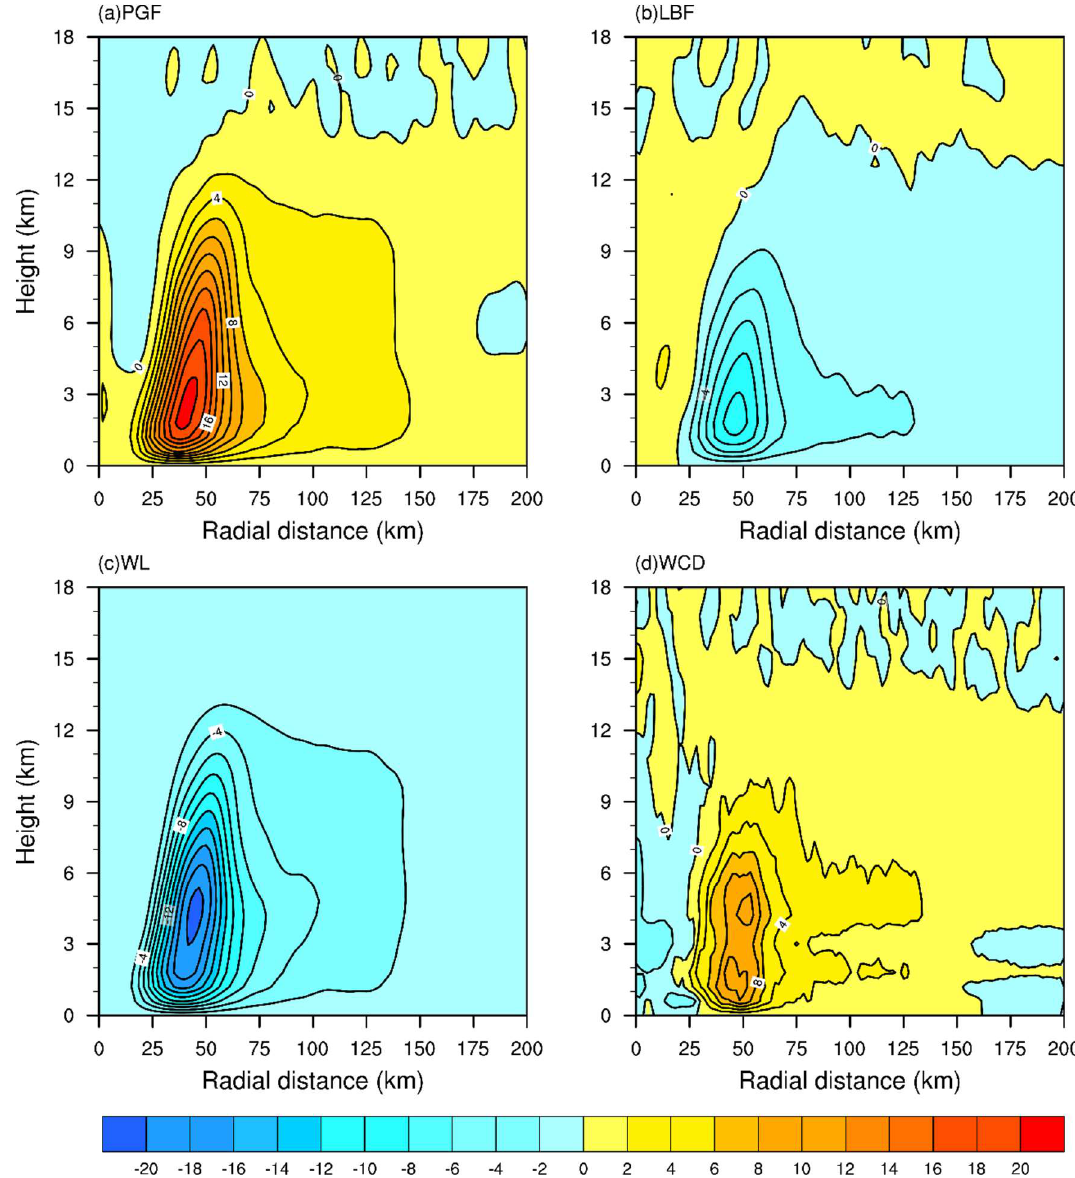
Figure 7. Height–radius cross-sections of the temporally and azimuthally averaged budget terms for ( a ) vertical perturbation pressure gradient force (PGF) (10 − 3 m s − 2 ), ( b ) local buoyancy force (LBF) (10 − 3 m s − 2 ), ( c ) water loading (WL) (10 − 3 m s − 2 ) and ( d ) Coriolis and diffusion effects (WCD) (10 − 3 m s − 2 ) for CTRL averaged between 84 h and 96